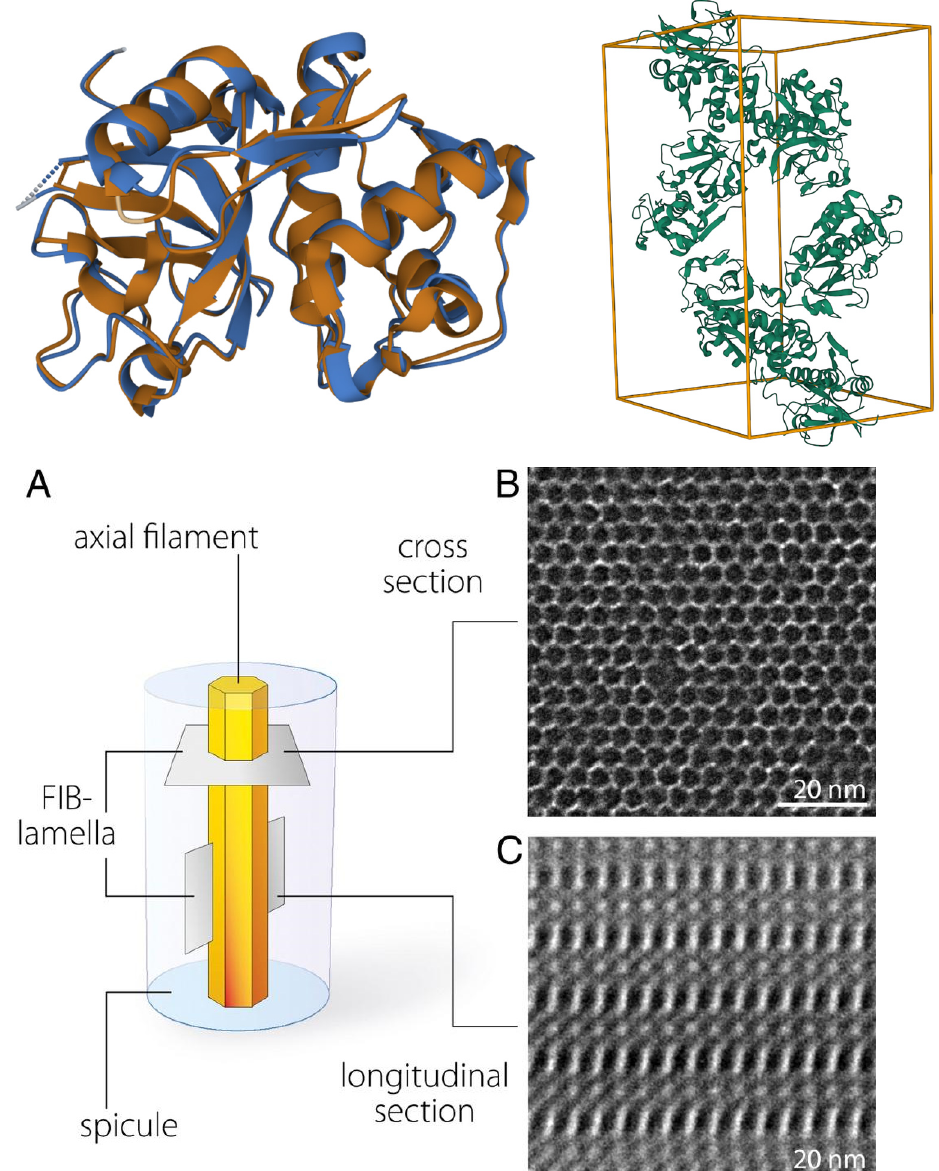
Figure 4. ( Upper panel, left side ) Superposition of α -silicatein (PDB entry 6zq3 [51], blue color) and human cathepsin L (brown color) reveals similarities between these two proteins (rmsd 0.65 Å, 211 C α atoms). ( Upper panel, right side ) Asymmetric unit crystal packing of α -silicatein reveals the regions available for filling with amorphous silica in a spicule specimen. This packing was also observed from transmission electron microscopy imaging of the real spicule specimen. ( Lower panel, Left side ) ( A ) Schematic representation of the studied slice of spicule sample by Focused Ion Beam (FIB) milling. This method allows for the preparation of thin slices of a specimen to be imaged through cryo-electron tomography. ( B , C ) Images obtained by studying the cross-section (along the [ 001 ] zone axis) ( B ) and the longitudinal section (along the [ 100 ] zone axis) ( C ) of the axial filament as depicted in A. The scheme and photographs were reprinted with permission from Ref.